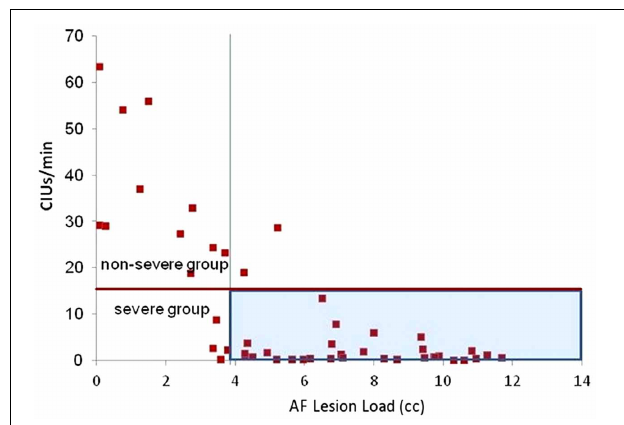
FIGURE 7 | Speech Fluency Classification of severe and moderately/mildly affected speech fluency outcome (shown by red horizontal line) at 15 CIUs/min. The vertical line is at 3.75 cc of AF-LL determined by the ROC curve as the threshold for classifying severe outcome, which is highlighted in